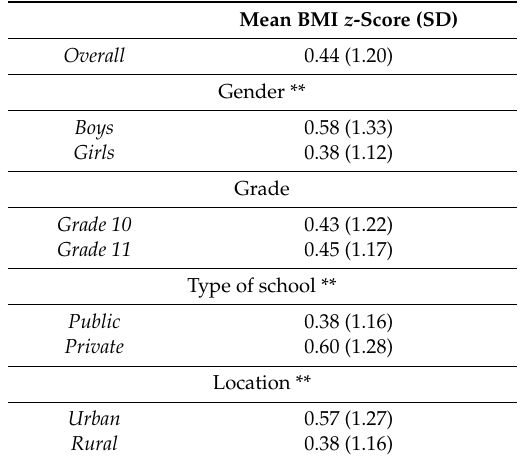
Table 3. Means of BMI z -scores among Lebanese